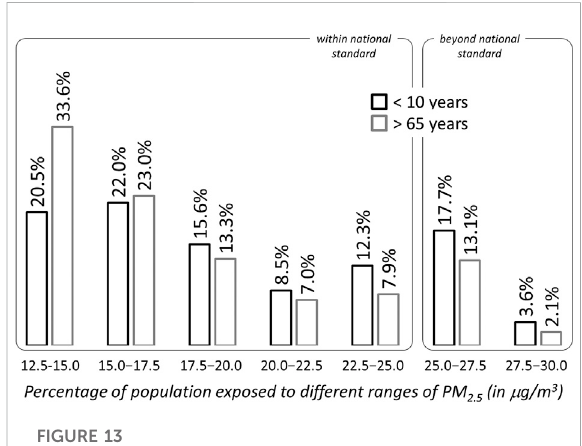
FIGURE 13 Exposure to PM 2.5 concentration of children and elderly.